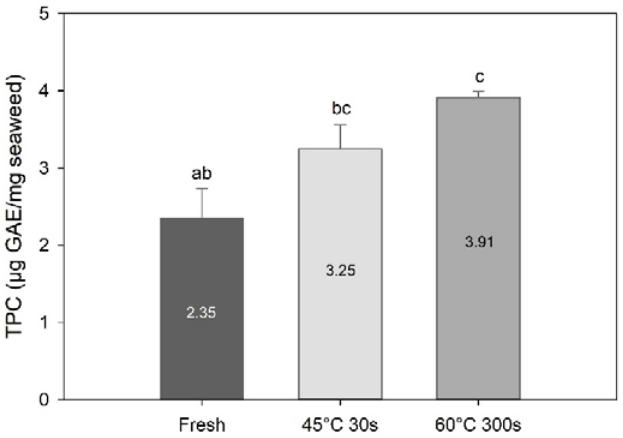
Figure 5. Total phenolic content of fresh and selected blanched samples of Saccharina latissima expressed in gallic acid equivalents per mg of freeze ‐ dried samples. Data are mean ± SD; n = 3. Different letters represent a significant difference between treatments ( p ˂ 0.05).